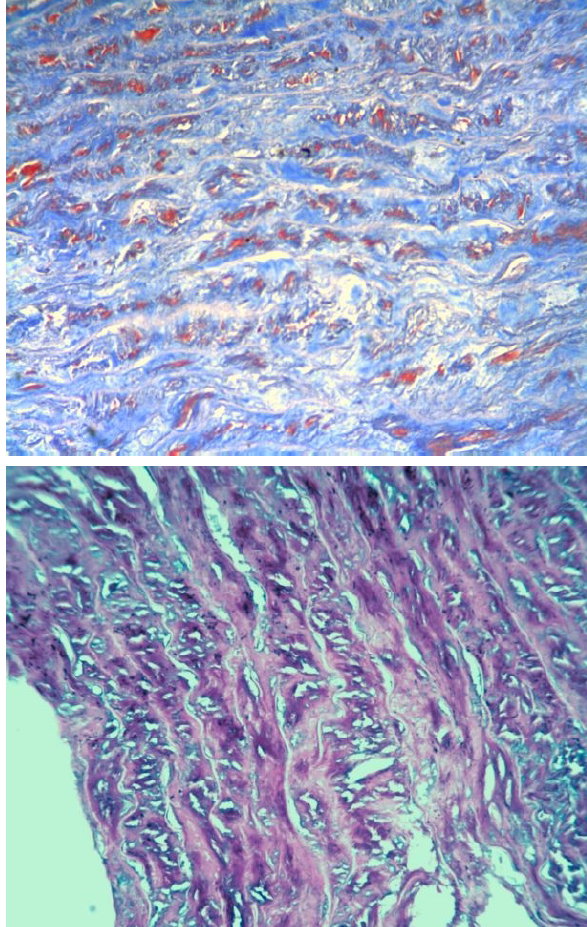
Fig. 5 – Histology of the ascending aorta of a 59-year-old male patient with coronary artery disease. The specimen was taken from the proximal anastomotic sites of the ascending aorta during coronary artery bypass grafting. (A) More collagens deposited in the disrupted aortic media; Masson×200; (B) More extensive and small and moderate cystic-like lesions in the aortic media. AB-